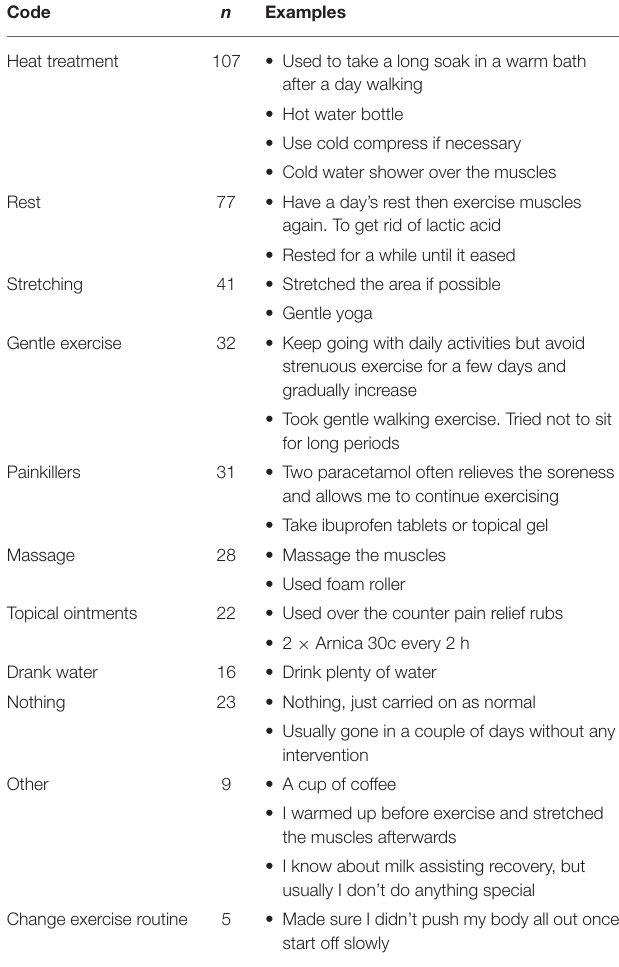
TABLE 1 | Exercise recovery strategies reported by older adults a